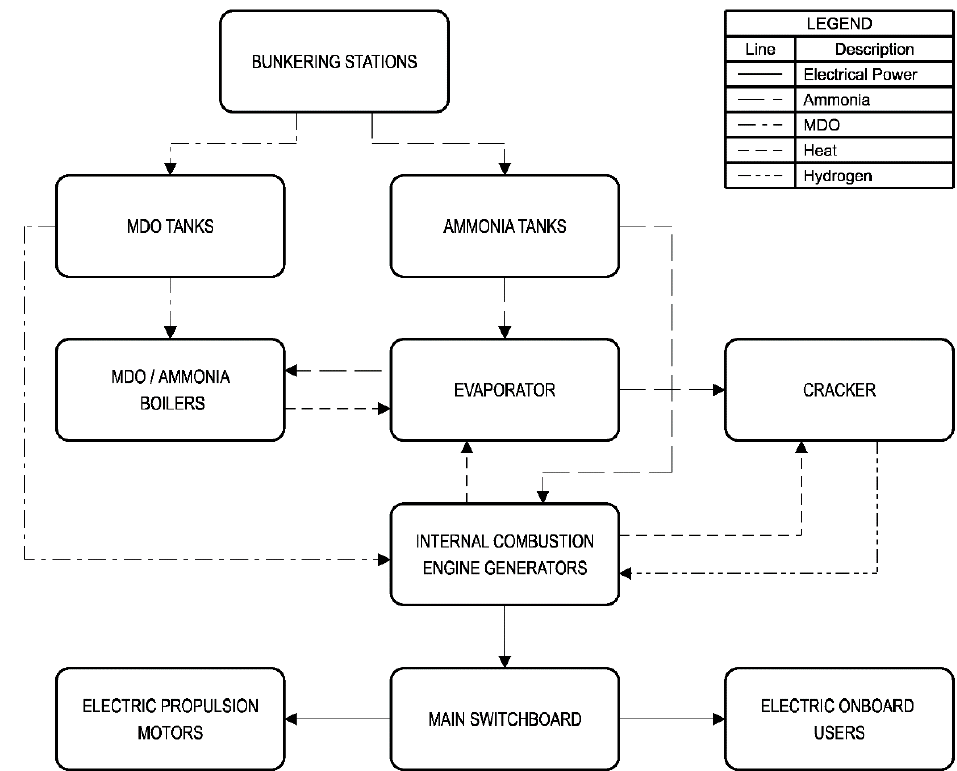
Figure 7. Ammonia power system scheme.